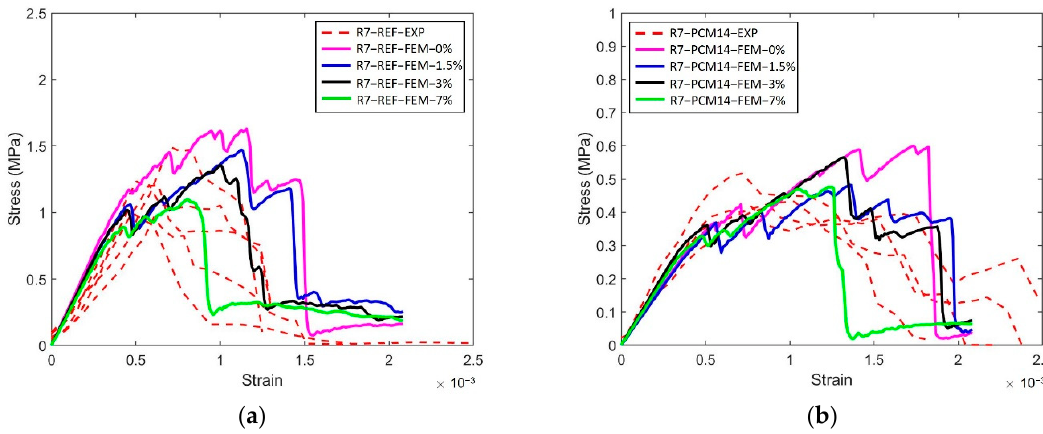
( c ) Figure 26. Crack pattern of the LCCCs, ( a ) R0, ( b ) R3 and ( c ) R7. Figure 27. Simulated damage pattern of the LCCCs, plastic strain is indicated. The influence of Voronoi randomness and mPCM on the in-plane strength is also visible in Figure 24. The difference between in-plane and out-of-plane strength decreases with respect to the Voronoi randomness; moreover, the mPCM incorporated LCCCs (R7-